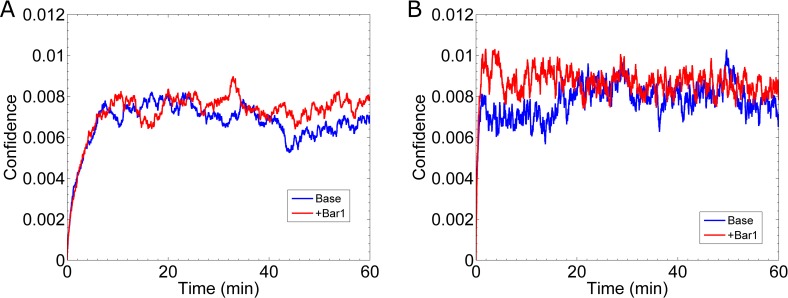
Gradient Estimation During Formation of the Gradient.(A) Result for the cell’s confidence (Eq 9) in the direction of the gradient for slow binding kinetics. In these simulations the emerging gradient is 0.1 nM/μm with a mean of 6.9 nM. The blue curve, labeled “Base”, is for the case without Bar1, and the red curve, labeled “+Bar1”, includes the effect of Bar1. The “Base” data is the mean of the same twenty simulations from Fig 9A, and the “+Bar1” data is the mean of sixteen simulations. (B) Same as (A) except for fast kinetics. The “Base” data is the mean of the same twenty simulations from Fig 9B, and the “+Bar1” data is the mean from sixteen simulations.